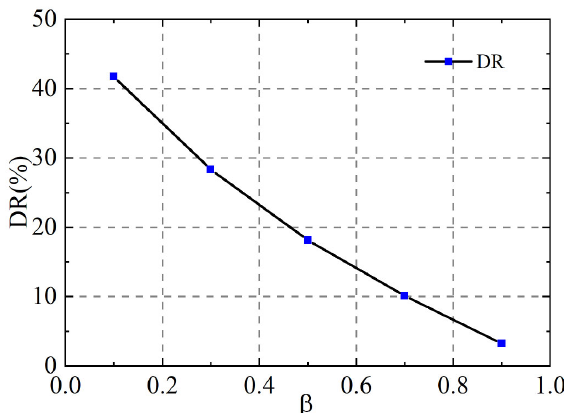
Figure 18. Drag reduction rate of different solvent viscosity ratios ( β ).